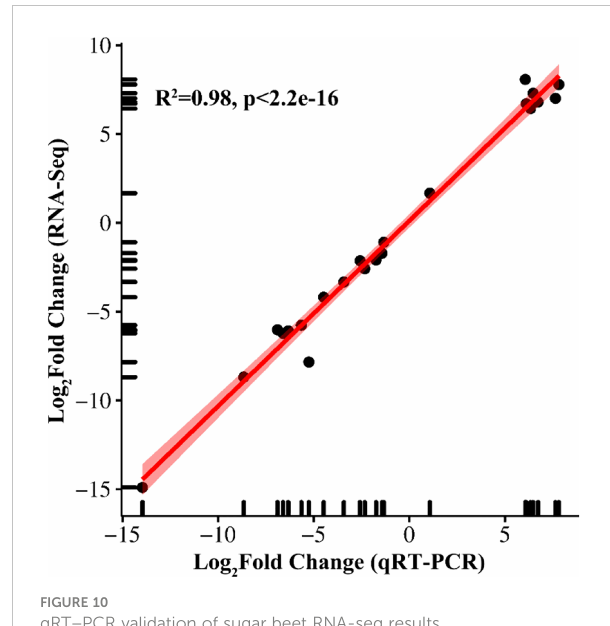
FIGURE 10 qRT − PCR validation of sugar beet RNA-seq